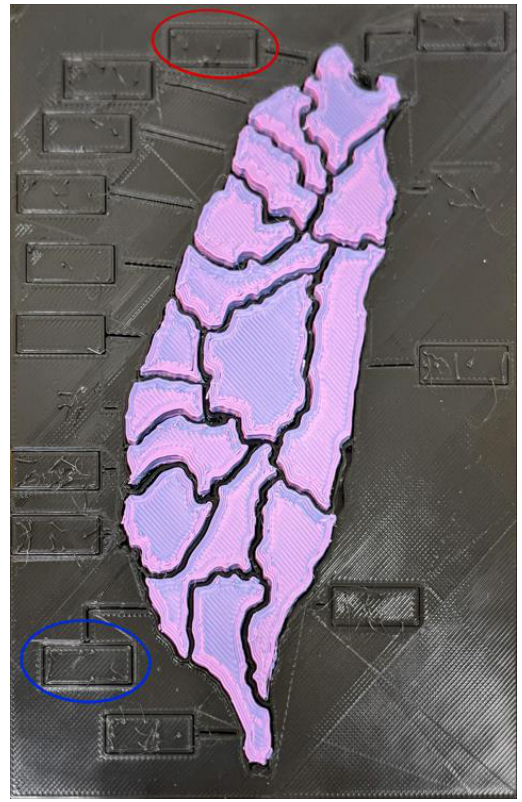
Figure 6. Sample of a tactile map of Taiwan (where the contracted name of each city is used ( 北— bei for 臺北市 — Taipei City in red, 高 — gao for 高雄市 — Kaohsiung City in blue, etc.) generated, and 3D printed in Chinese Braille.